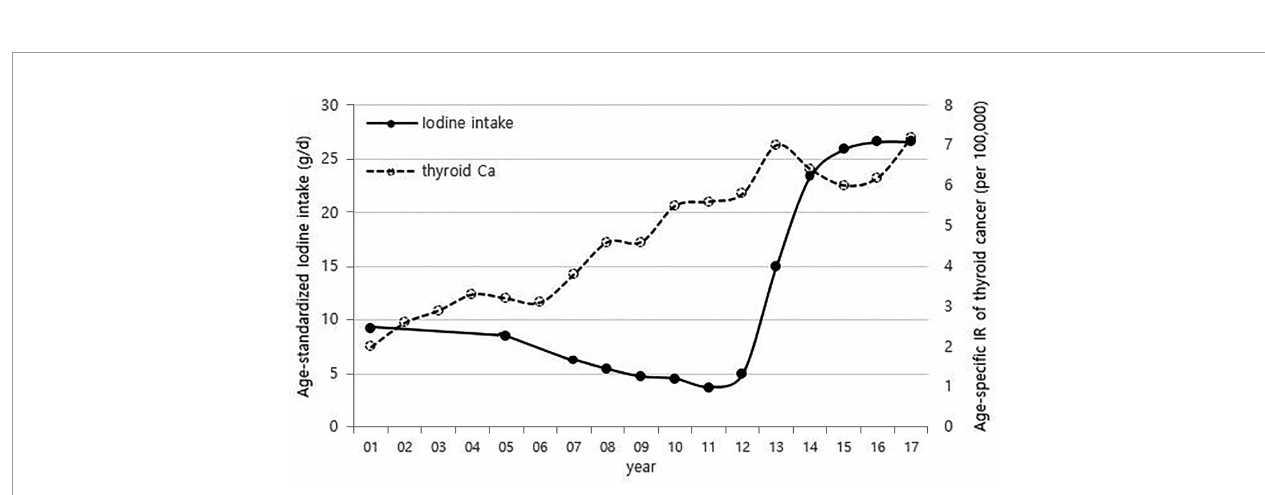
FIGURE 3 | Correlation between age-standardized iodine intake (2007-2017) and age-speci fi c incidence rate of childhood thyroid cancer (0-18 years) by year in Korea (1999-2017, per population of 100,000). Broth foods were added to the survey since 2013. Ca, cancer; IR, incidence